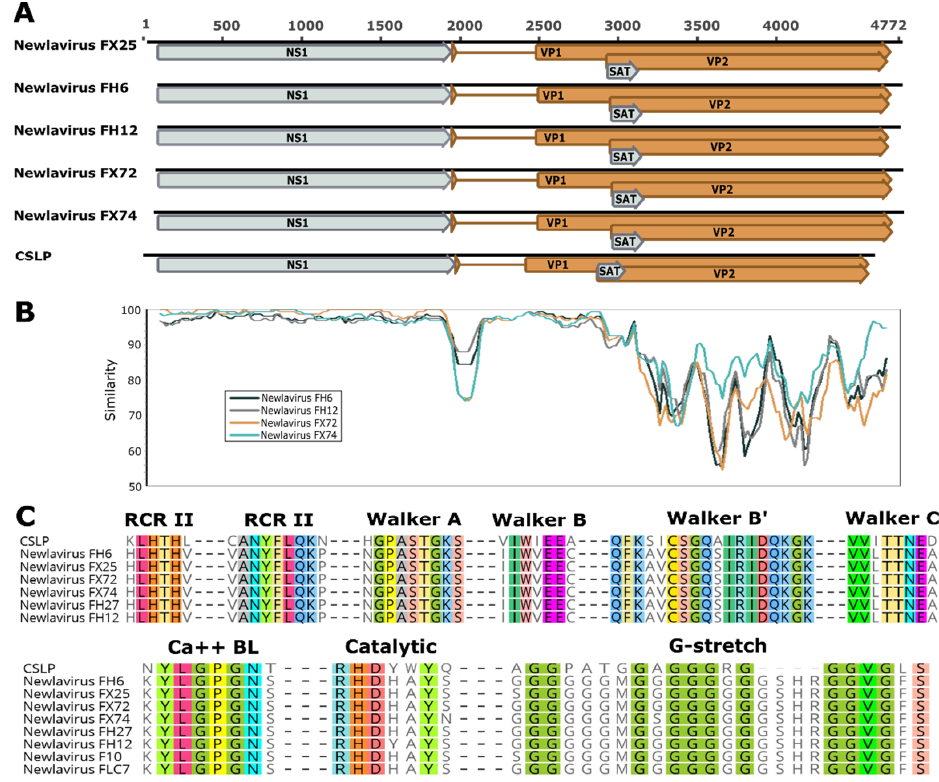
Figure 2 . Genomic features of five Newlavirus strains compared to those of the California sea lion parvovirus (CSLP). ( A ): schematic genome representations with in silico predicted ORFs. ( B ): nucleotide identities throughout the genomes of four strains compared to the FX25 reference strain. ( C ): conserved motifs typical of parvoviruses. Rolling circle replication (RCR) and Walker motifs typical of NS1 are shown at the top and phospholipase A2 (Ca++ BL: calcium binding loop; Catalytic: catalytic site) and glycine-rich (G-stretch) motifs typical of VP1 at the bottom.